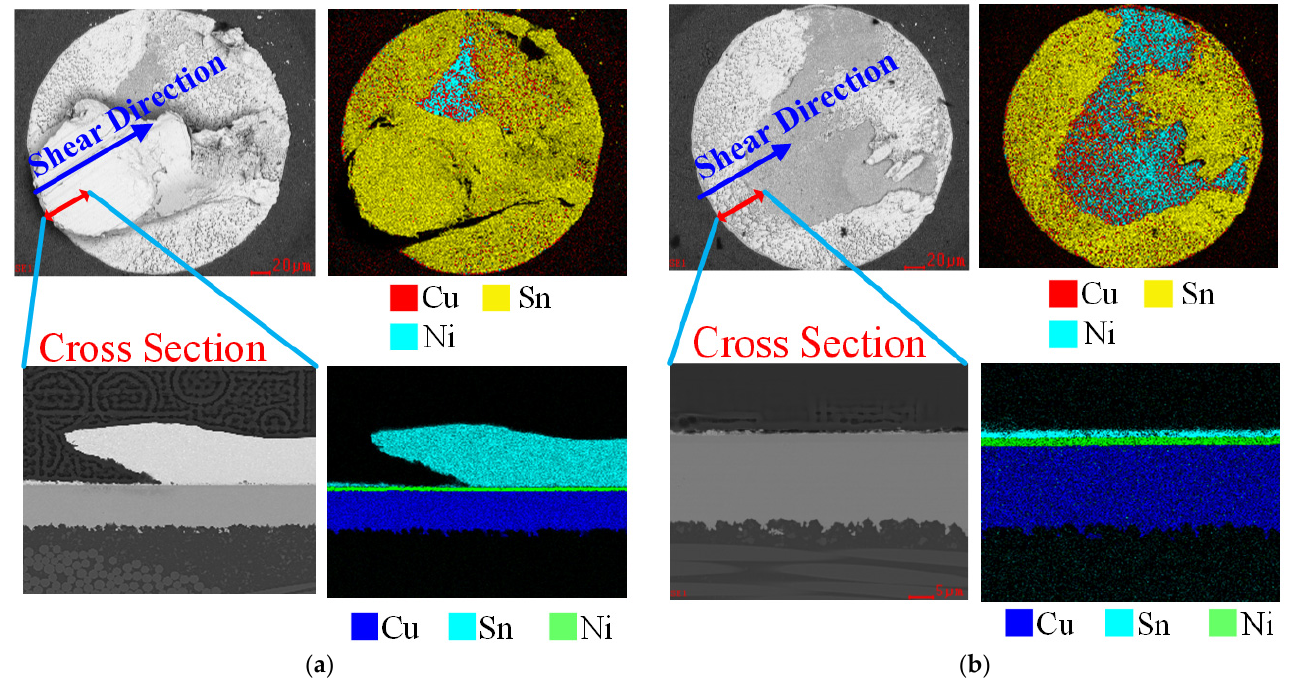
Figure 7. Surface, partial cross-section and chemical element distribution figures of two fracture modes: ( a ) solder bulk fracture; ( b ) solder/pad interface fracture. modes: ( a ) solder bulk fracture; ( b ) solder/pad interface